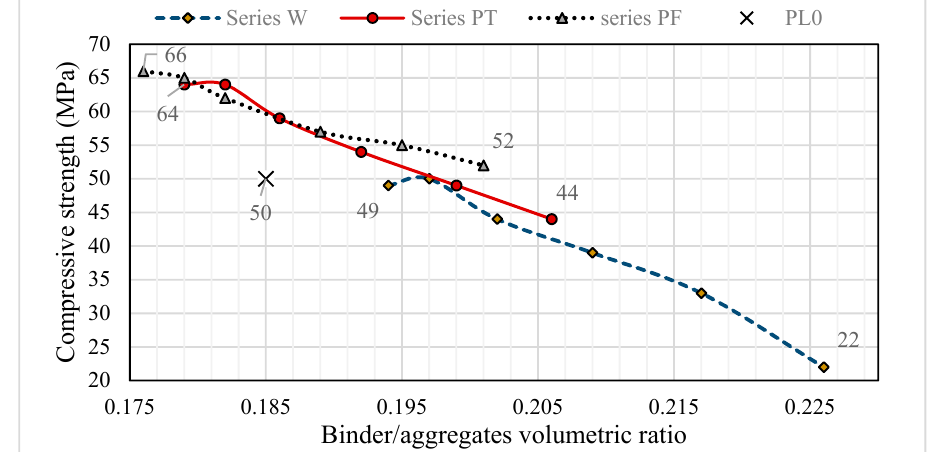
Figure 11. f cm versus binder/aggregates volumetric ratio.